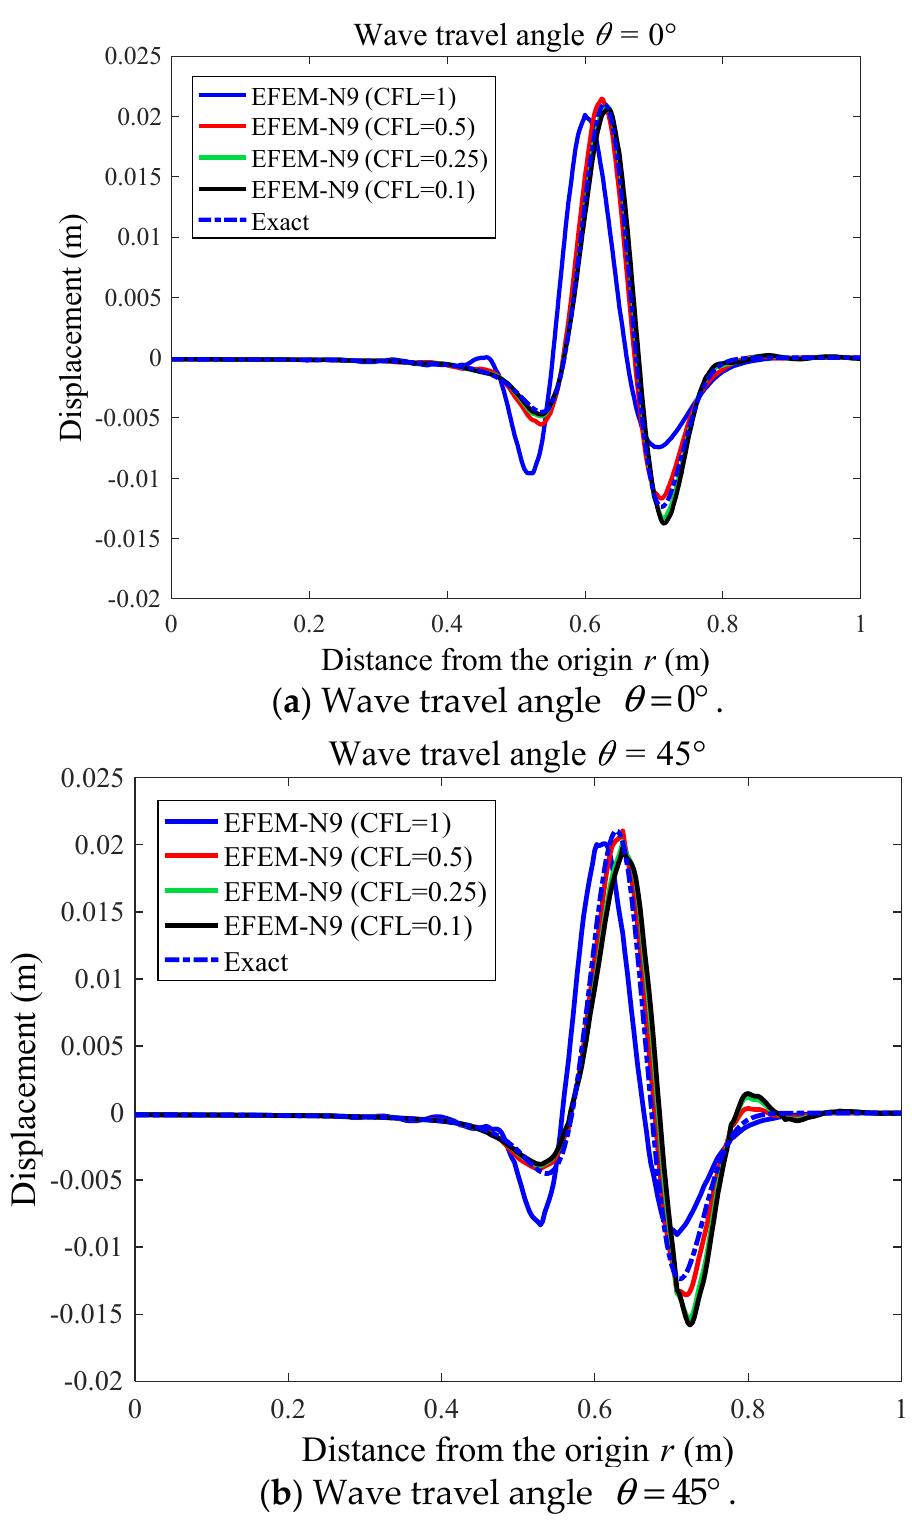
Figure 11. The displacement responses of the square membrane from the EFEM-N9 by varying the employed nondimensional temporal discretization